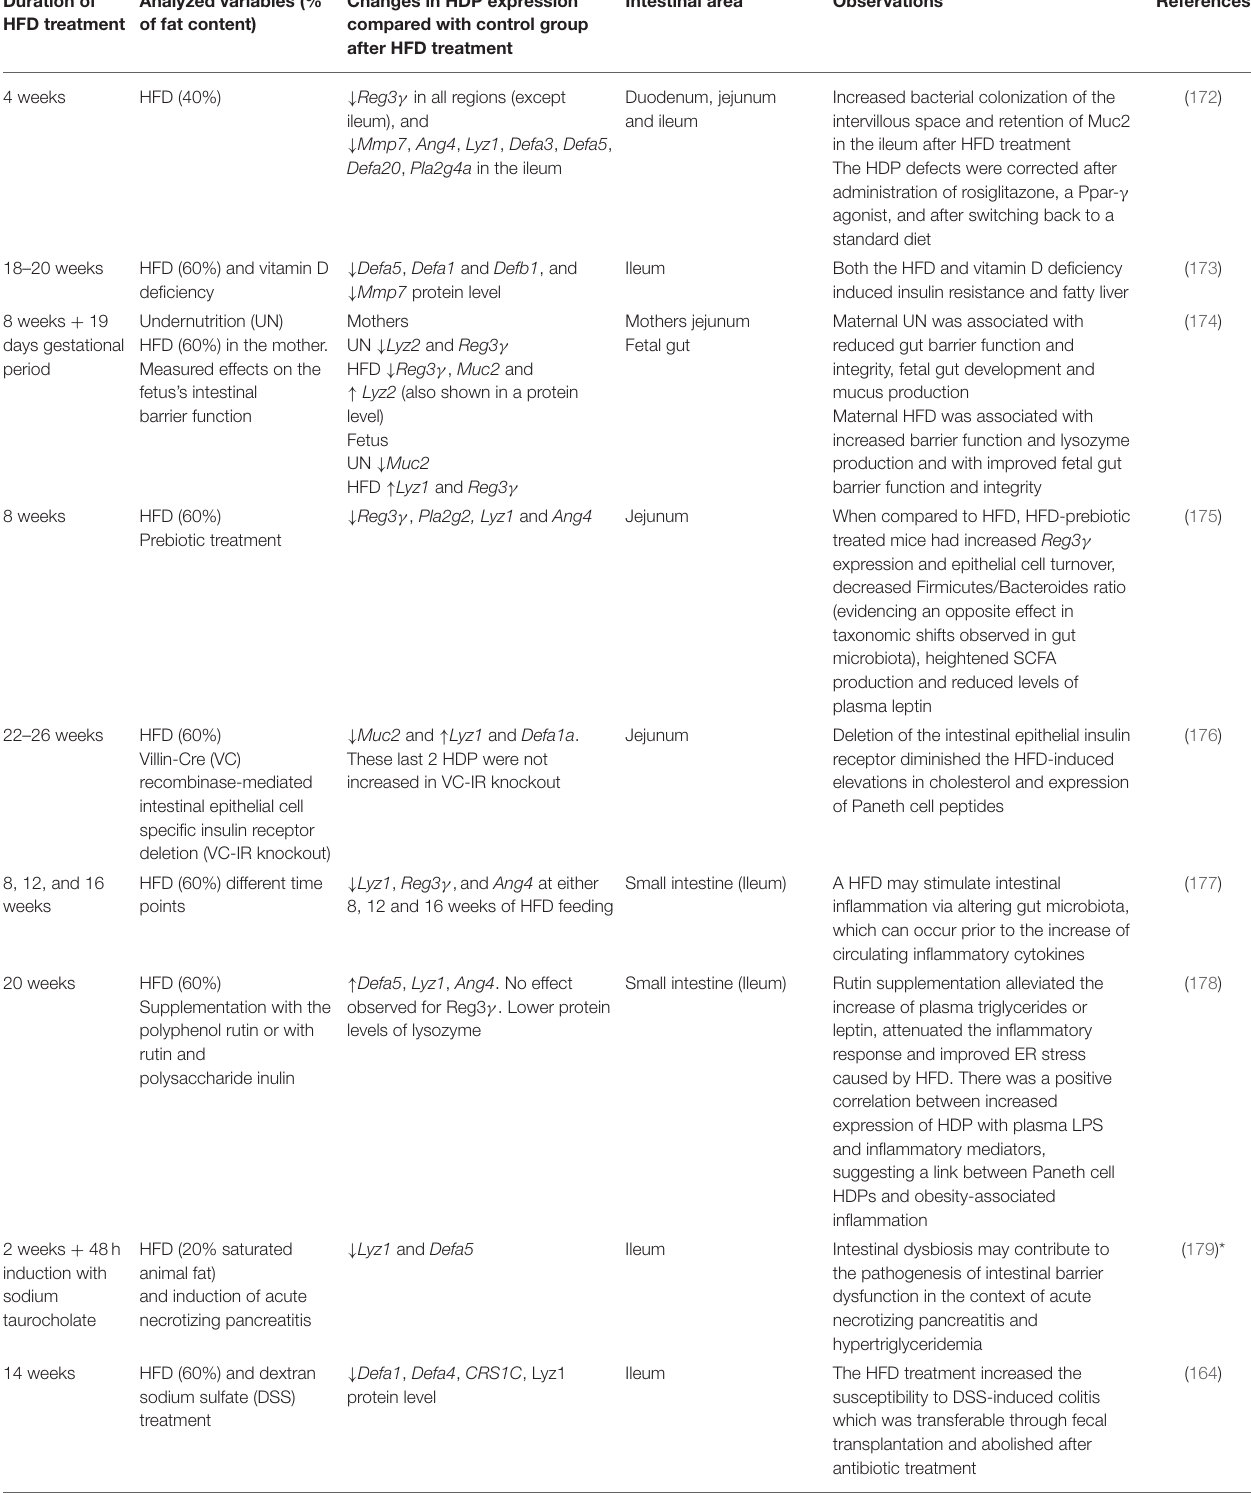
Intestinal area